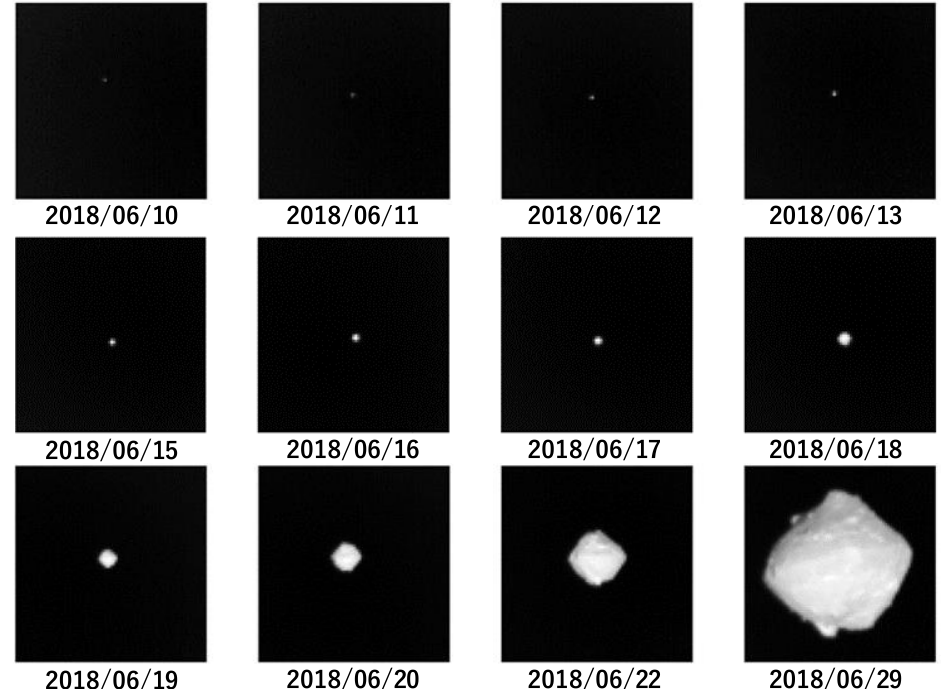
Figure 2. Thermal images of asteroid 162173 Ryugu taken by TIR during the Approach Phase (© JAXA).